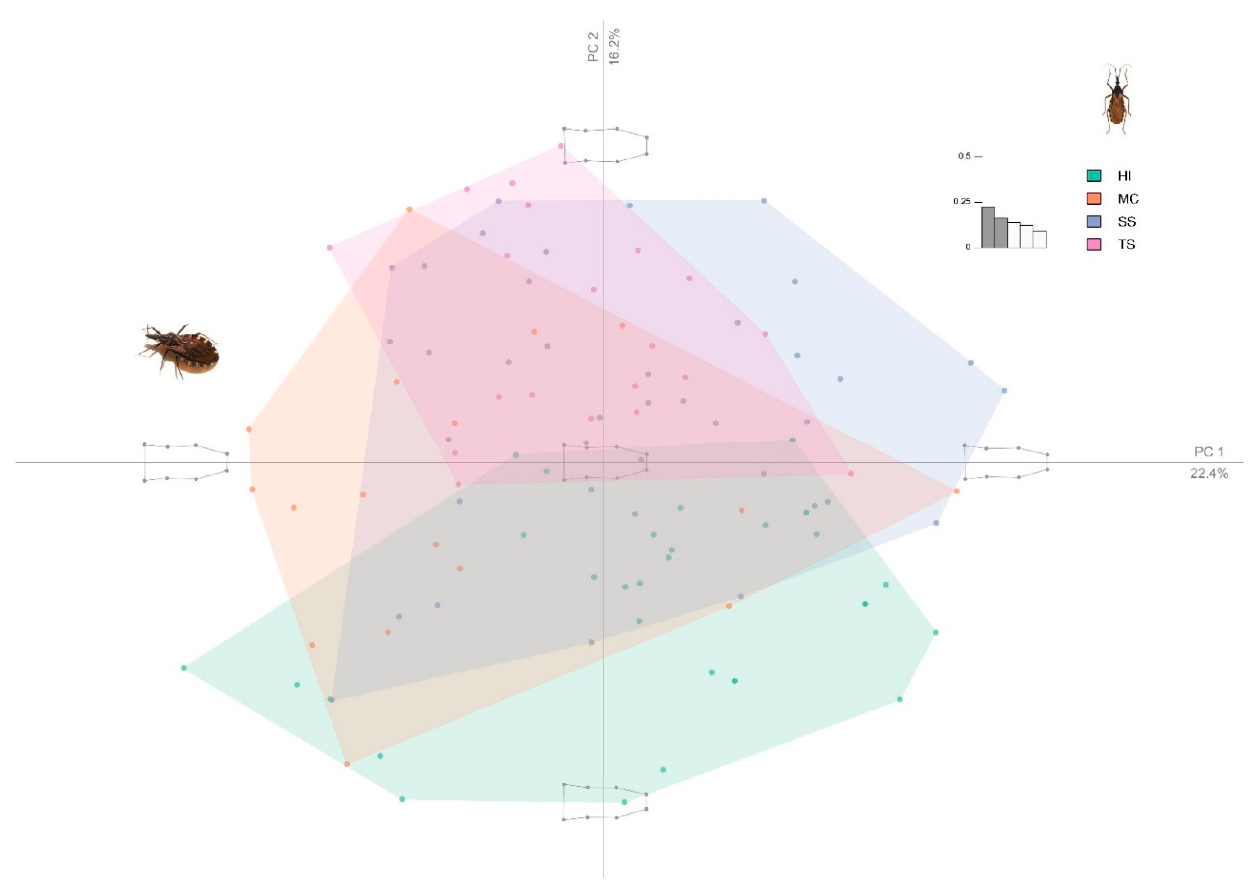
Figure 3. PCA of the Triatoma infestans head dorsal view in four populations. Color code: green: Huacaya/Imbochi (HI); orange: Monteagudo/Cañon Largo (MC); blue: Sucre/Surima (SS), and pink: Tarabuco/Sarufaya (TS).